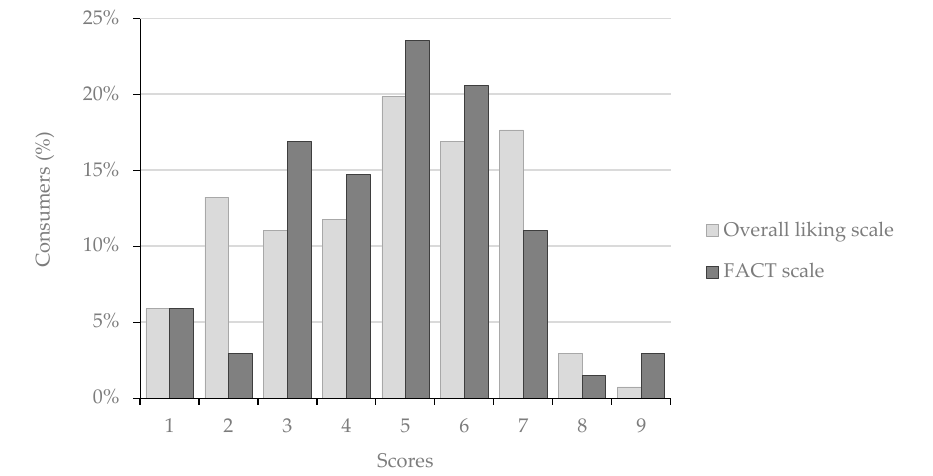
Figure 6. Distribution of consumers’ responses regarding overall liking and acceptance (FACT).